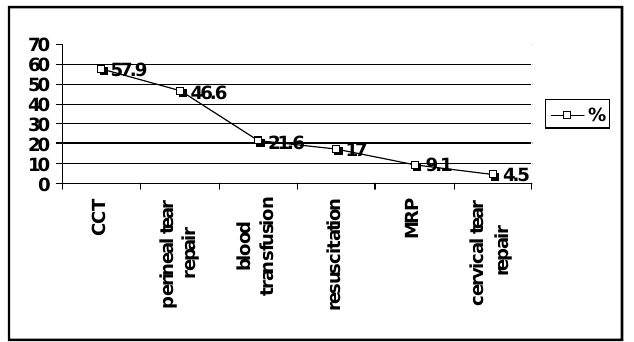
Fig.3 : Management in the